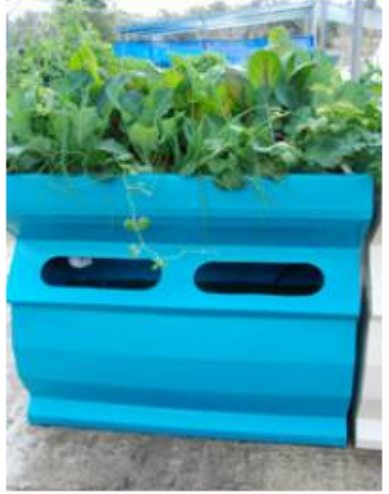
Figure 5. Backyard Aquaponics balcony Aquaponics (Backyard Aquaponics,